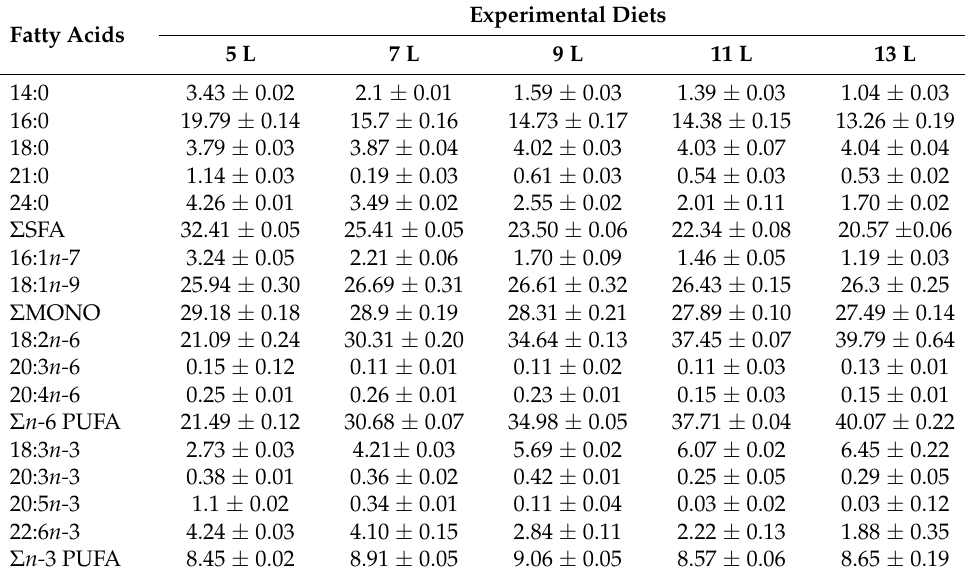
Table 2. Fatty acid composition (%) of experimental diets differs in their total crude